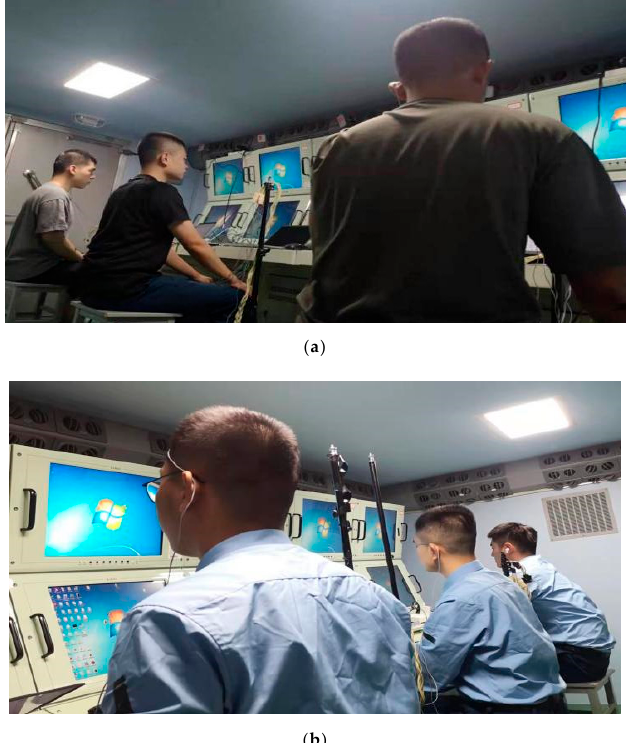
Figure 6. The subjects wearing long and short clothing in the manned shelter. ( a ) Short clothing experiment. ( b ) Long clothing experiment.